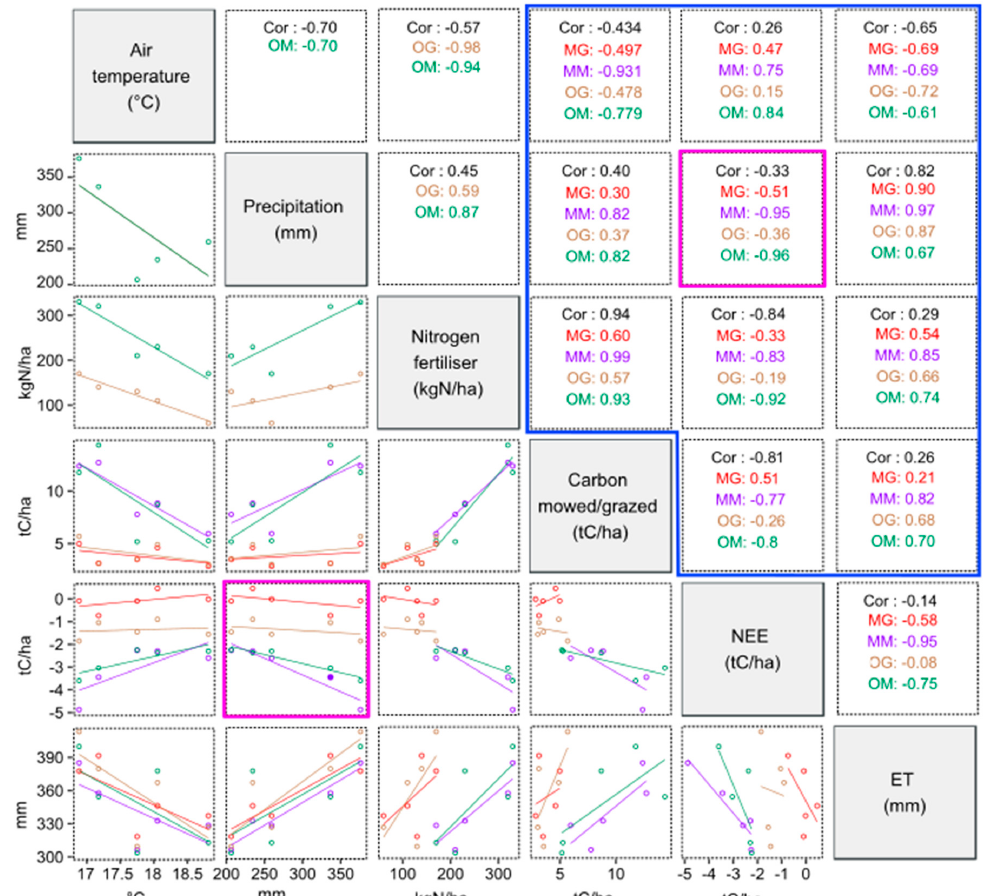
Figure 10. Matrix of paired plots showing the interannual variability of summer half-year (15th April–15th September) averaged climate drivers (air temperature and precipitation), management practices (N fertilizer application and amounts of C mowed/grazed), and observed and modeled CO 2 and H 2 O fluxes for the mowed and grazed grassland sites (MG: modeled grazing; MM: modeled mowing; OG: observed grazing; OM: observed mowing). Variable names are given in the matrix diagonal. Paired scatterplots are in the lower triangle (below the diagonal in gray) with every point being the summer half-year of one year of the study period and colors are related to the different categories listed above. Their corresponding Pearson (linear) correlation coefficients are listed in the upper triangle (above the diagonal in gray). For example, the relationships between NEE and precipitation is shown in the pink circled scatter plot below the matrix diagonal and corresponding correlation coefficients for the different categories are given in the symmetric panel above the matrix diagonal (pink-circled). Important relationships are circled in blue on the upper panels. For the mowed paddock, observed, and modeled amounts of carbon harvested are highly correlated with air temperature (OM: − 0.78 and MM: − 0.93), precipitation (OM and MM: 0.82), and N